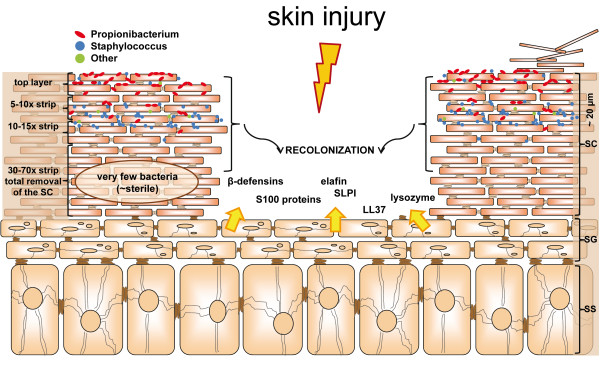
Model for skin injury, microbial recolonization, and host response. Details in Discussion and Conclusion sections. Recolonization is done by bacteria from the deeper layers of the adjacent skin (black arrows). During this process the microbial communities of the host and invading bacteria from the environment trigger the skin to express antimicrobial proteins and inflammatory molecules (yellow arrows). SC = stratum corneum; SG = stratum granulosum; SS = stratum spinosum.